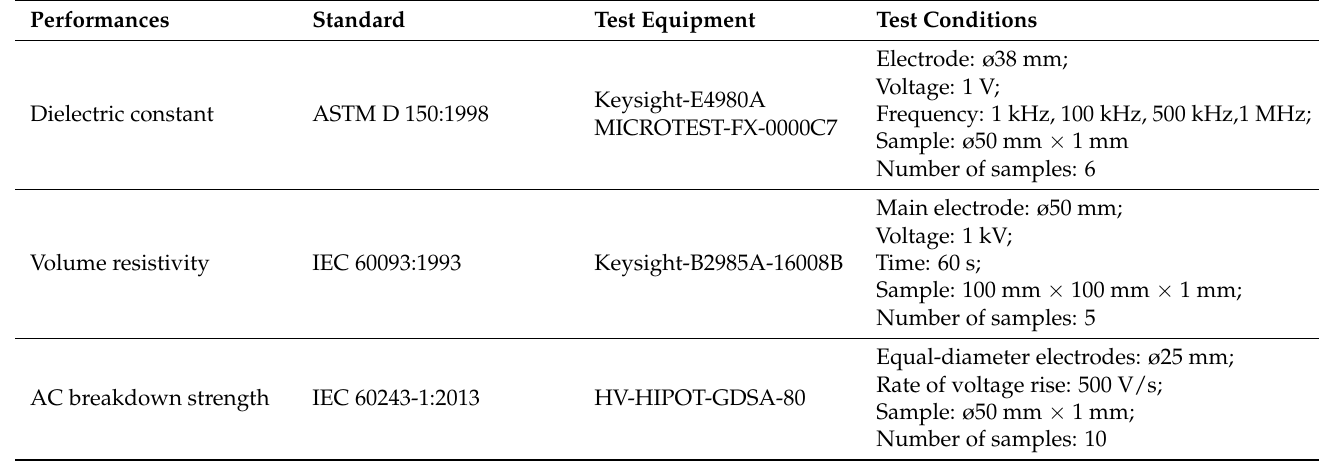
Table 2. Samples for the electrical property tests, standards, test conditions and test equipment.